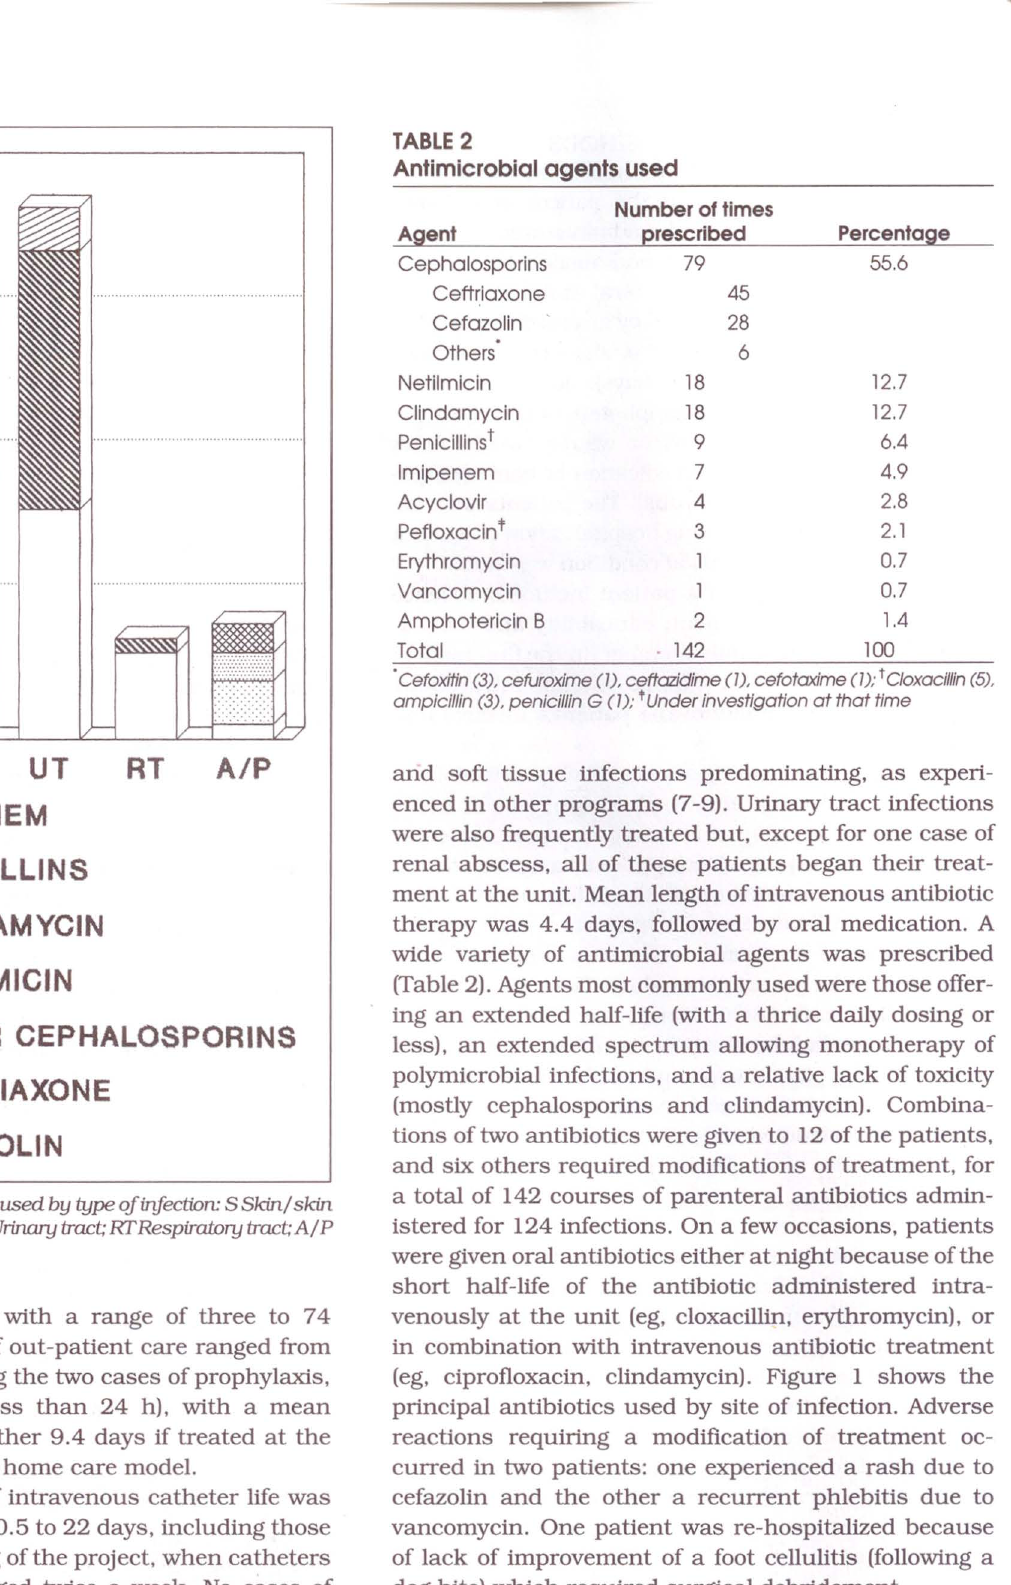
Antimicrobial agents